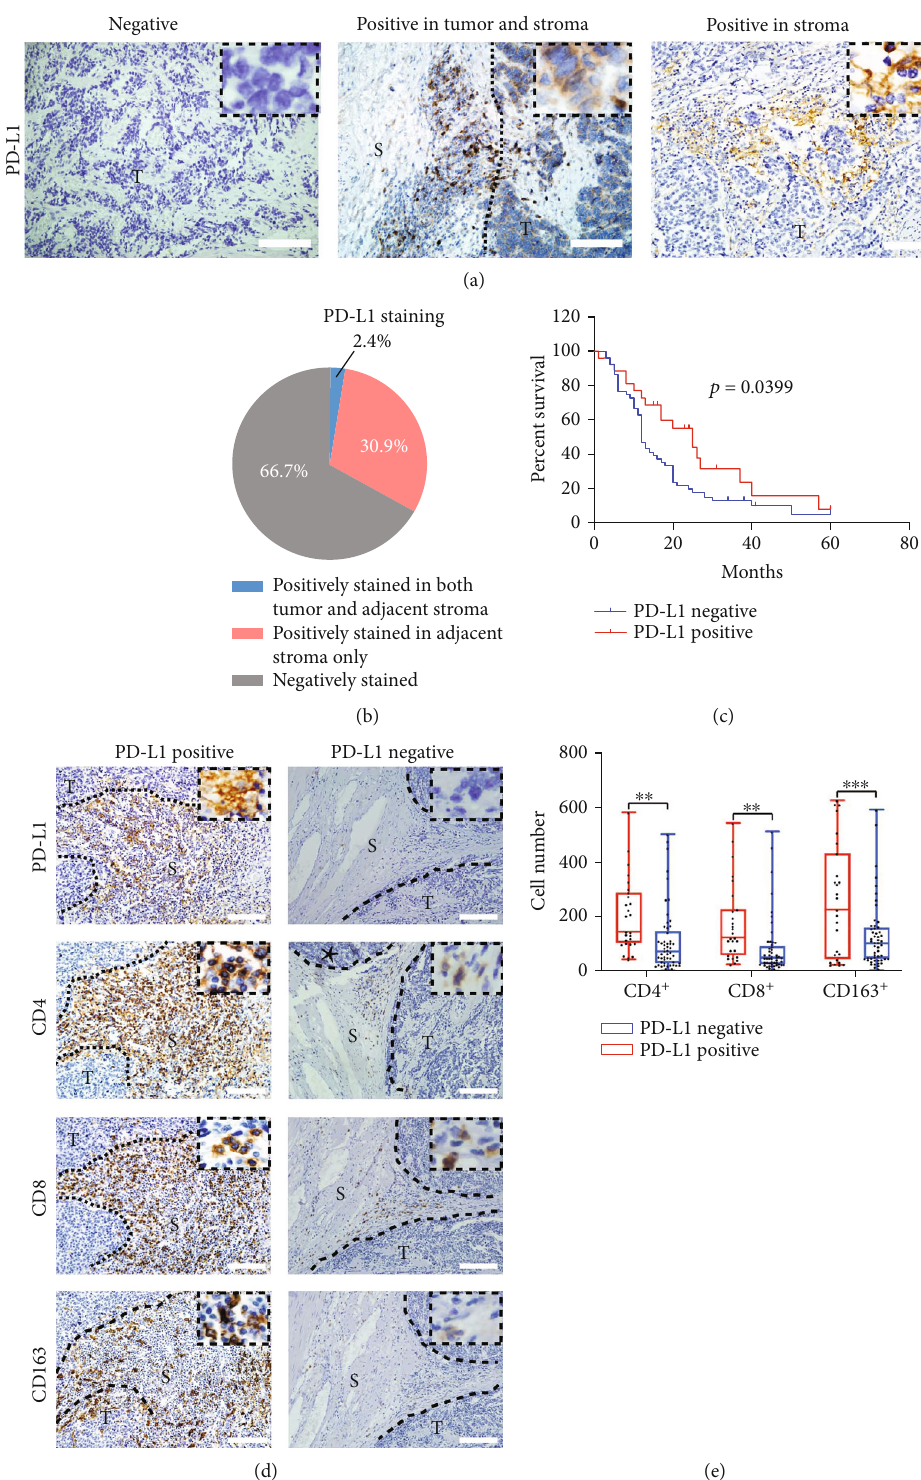
Figure 1: The expression of PD-L1 in the stroma correlates with tumor-in fi ltrating immune cells in PESCC. (a) Representative immunohistochemistry (IHC) images showing di ff erent expression patterns of PD-L1 in PESCC tissues. Scale bar, 100 μ m. S: stroma; T: tumor. (b) Distribution of di ff erent expression patterns of PD-L1 are plotted in the pie chart. (c) The Kaplan – Meier survival analysis of overall survival (OS) in a cohort of 77 PESCC patients according to positive (red line, n = 26 ) and negative (blue line, n = 51 ) PD-L1 expression. (d) Representative IHC images showing PD-L1, CD4, CD8, and CD163 expression in the stroma using consecutive sections of PD-L1-positive and PD-L1-negative specimens. Scale bar, 100 μ m. S: stroma; T: tumor. (e) The presence of PD-L1 is positively associated with the number of CD4 + TILs, CD8 + TILs, and CD163 + TAMs ( ∗∗ p < 0 : 01 and ∗∗∗ p < 0 : 001 by the Wilcoxon